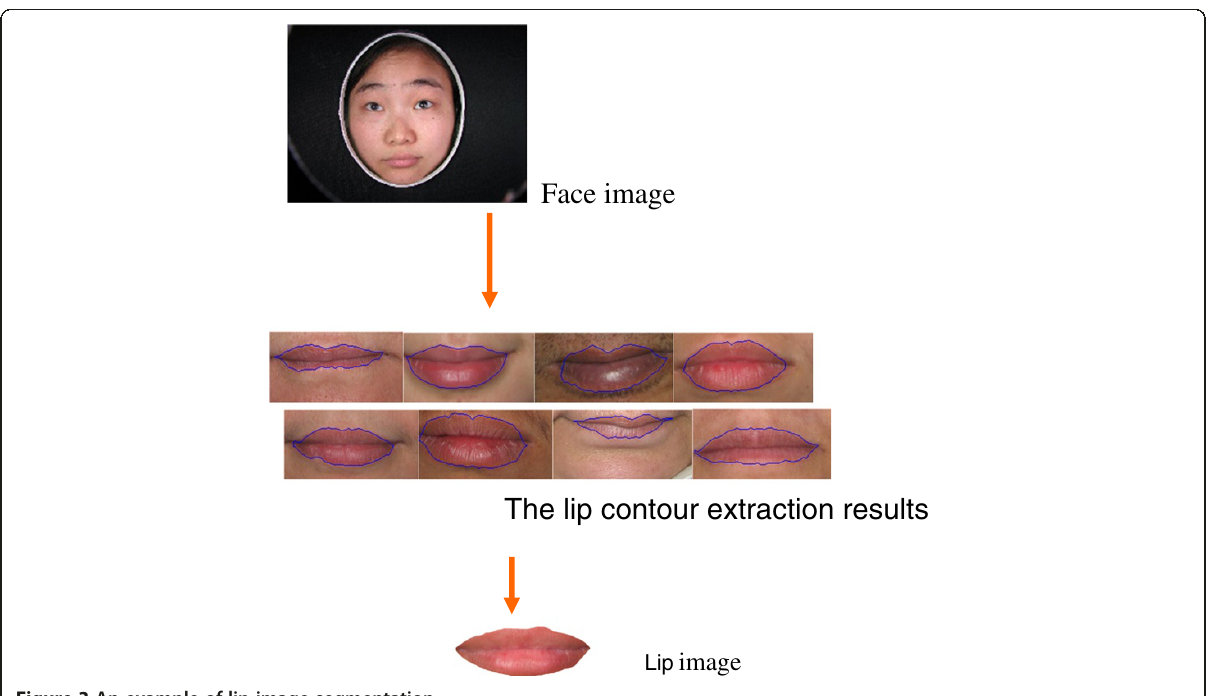
Figure 3 An example of lip image